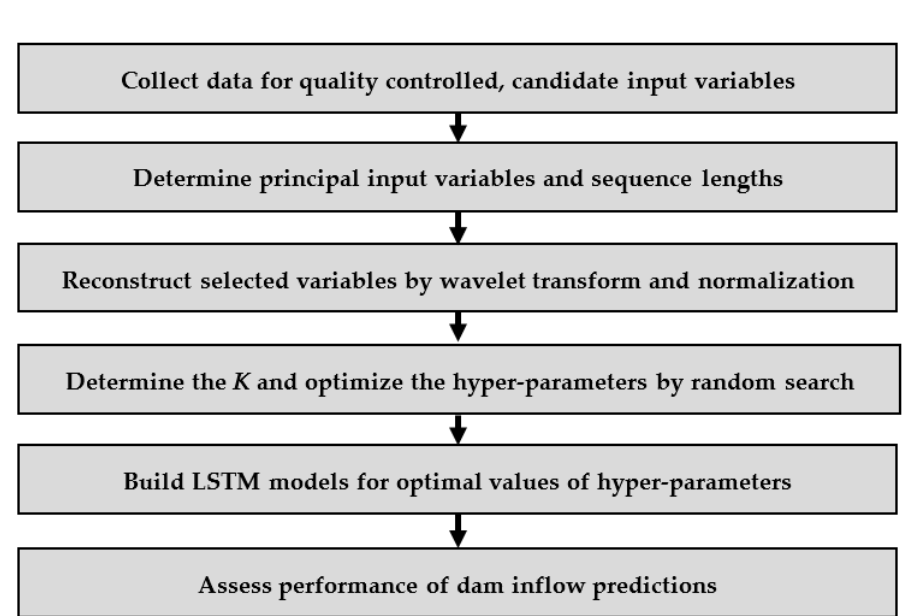
Figure 2. Flow chart of the methodologies adopted for predicting dam inflow.